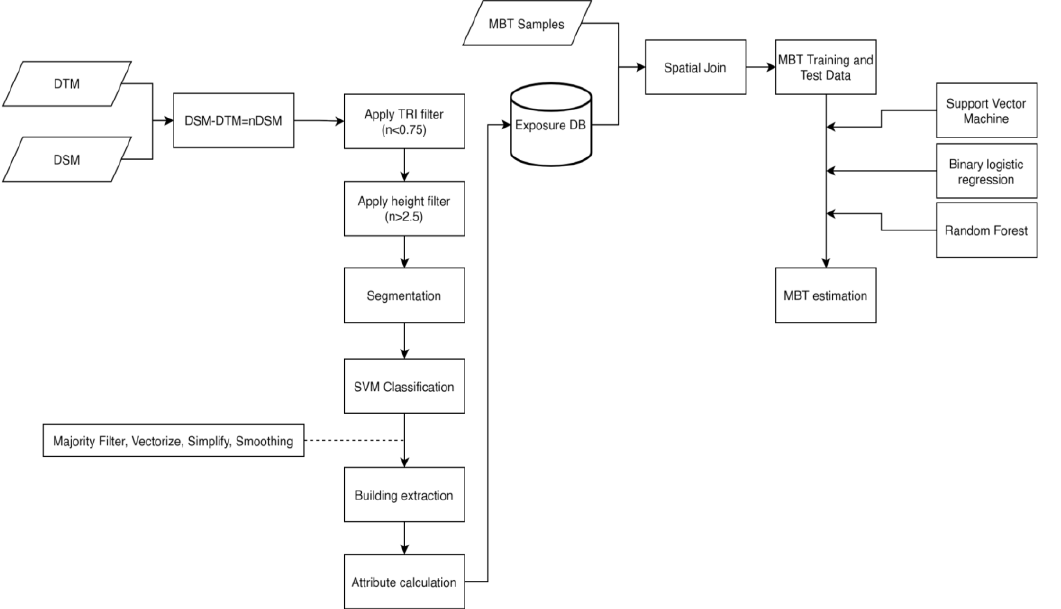
Figure 3. Flowchart of the proposed methodology.